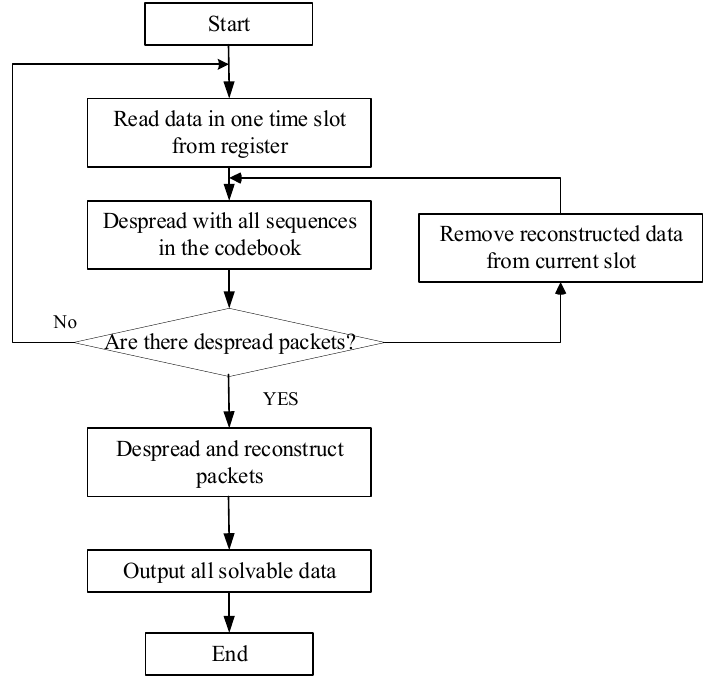
Figure 6. Flowchart of the conflict resolution algorithm.